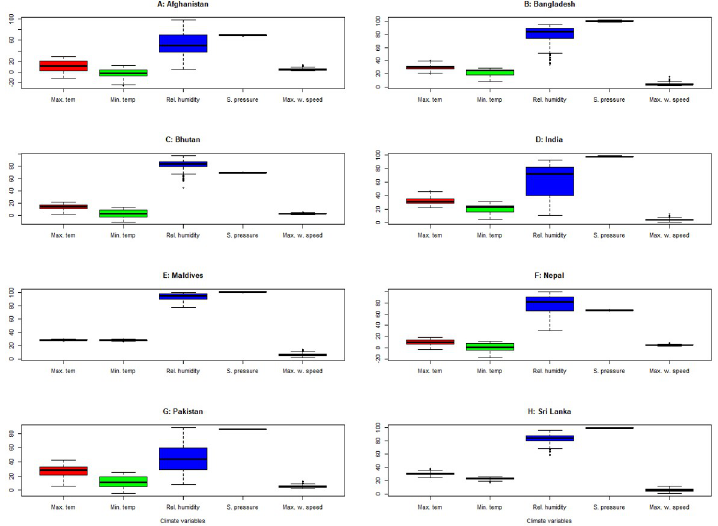
Fig 2. Boxplot of meteorological variables for SAARC countries. Max. tem: Maximum temperature; Min. temp: Minimum temperature; Rel. humidity: Relative humidity; S. pressure: Surface pressure; Max. w. speed: Maximum wind speed.